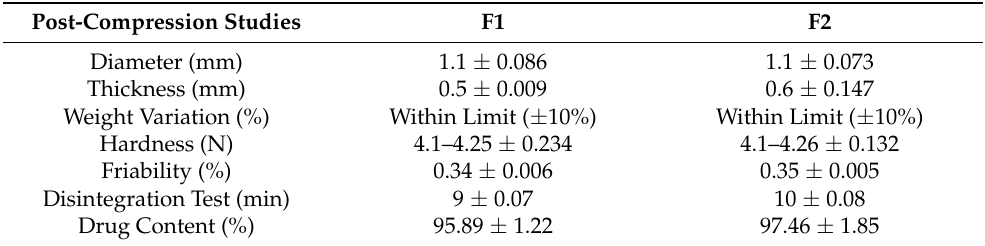
Table 6. Outcomes of post-compression studies of both PLX- and TPLX-based modified-release compressed tablets of TCM